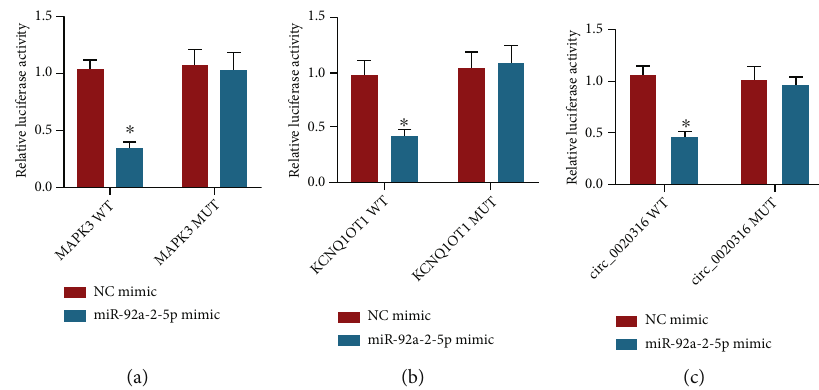
Figure 7: KCNQ1OT1 and circ_0020316 manipulate MAPK3 by binding to miR-92a-2-5p. (a) The targeting relationship between MAPK3 and miR-92-a-2-5p evaluated by dual luciferase gene reporter assay. (b) The binding relationship between KCNQ1OT1 and miR-92-a-2-5p evaluated by dual luciferase gene reporter assay. (c) The binding relationship between circ_0020316 and miR-92-a-2-5p evaluated by dual luciferase gene reporter assay. ∗ p < 0 : 05 , NC mimic treatment.